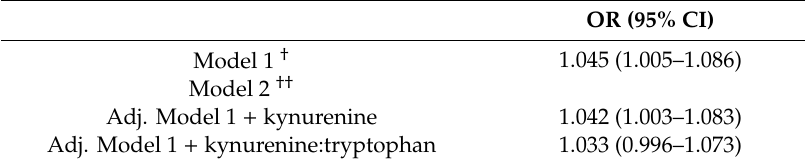
Table 7. Association between baseline hs-CRP and CKD incidence according to